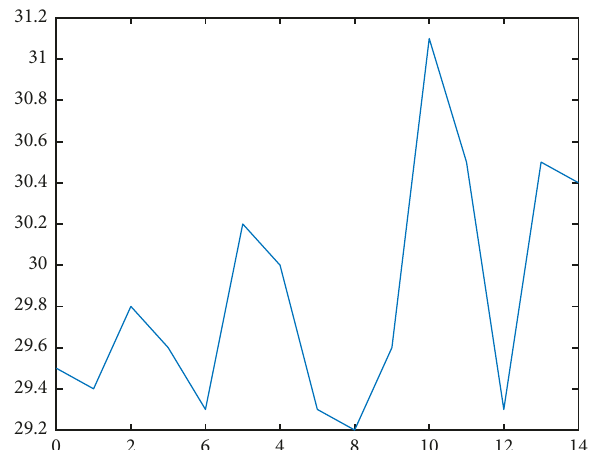
Figure 5: Measured temperature data. Table 1: Specific measurement